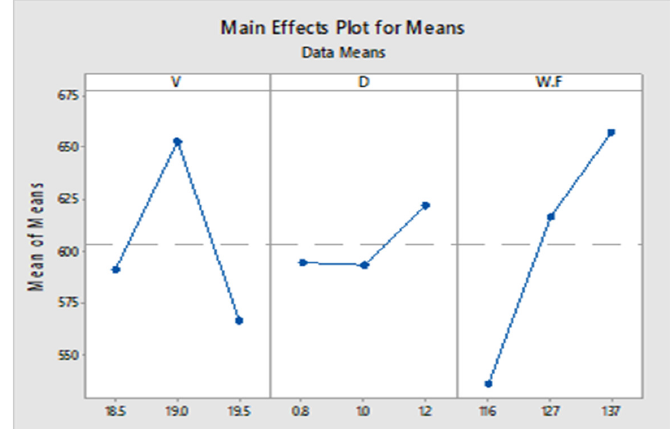
Fig. 6. Main effect plot of S/N ratio for UTS.